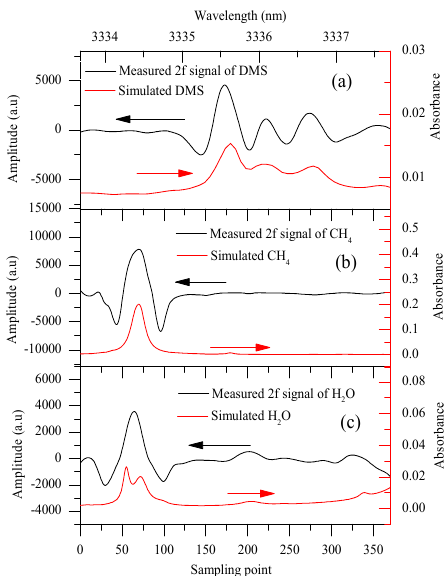
Figure 4. ( a ) The simulated absorbance and reference WMS-2f signals of DMS (20.2 ppm × 5 m); ( b ) the simulated absorbance and reference WMS-2 f signals of CH 4 (3 ppm × 5 m); and ( c ) the simulated absorbance and reference WMS-2 f signals of H 2 O, simulation data come from HITRAN database, 1 atm, 296 K.